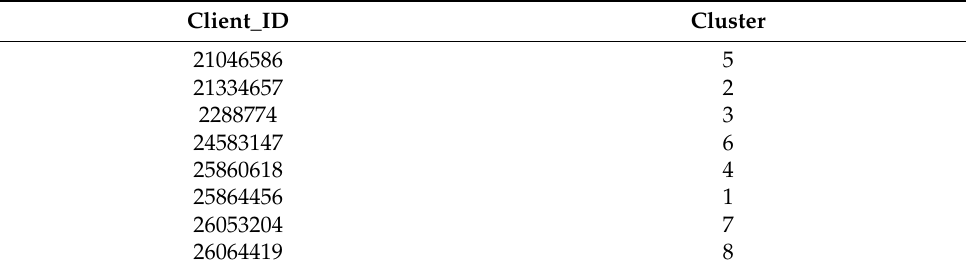
Table 14. Extract of RFID c for Some